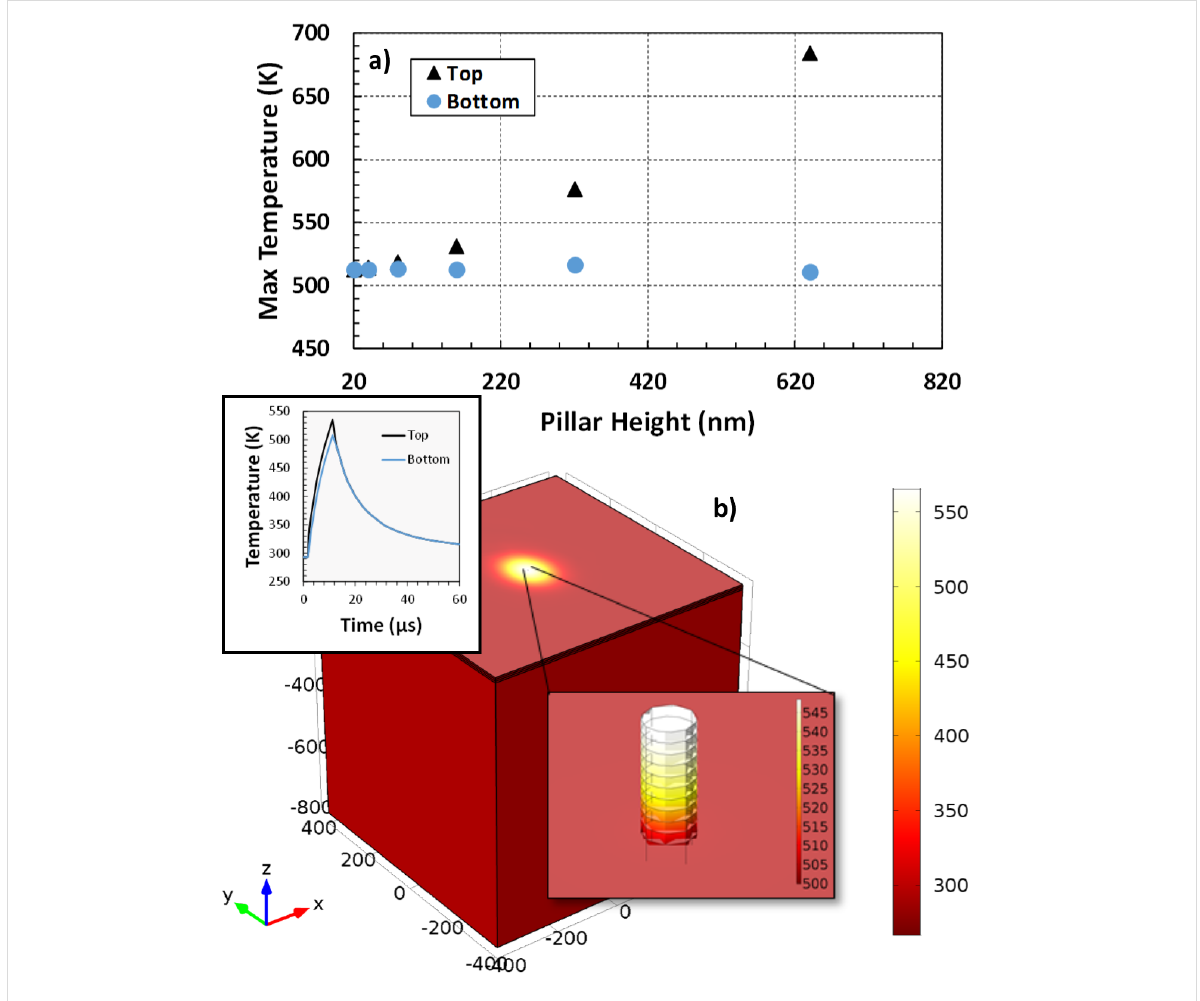
Figure 5: COMSOL™ simulation results showing the preferential heating at of the EBID deposit. a) is a plot of the maximum temperatures of both the top and bottom of the pillar at varying growth heights. The radius for the pillars was kept constant at 50 nm. b) shows the spatially resolved simulated temperatures in the system. Reading from right to left, the insets show a representative time-temperature plot for a single pillar grown to a height of 200 nm and a zoom-in on the